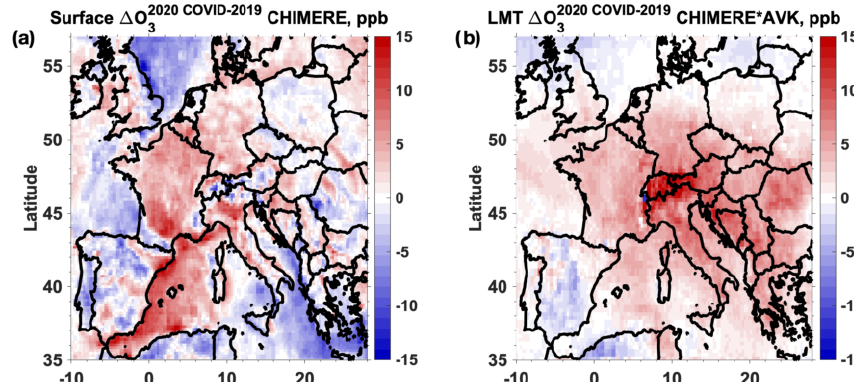
with the CHIMERE model coincident with daily IASI + GOME2 3 from CHIMERE smoothed by the averaging kernels of 3